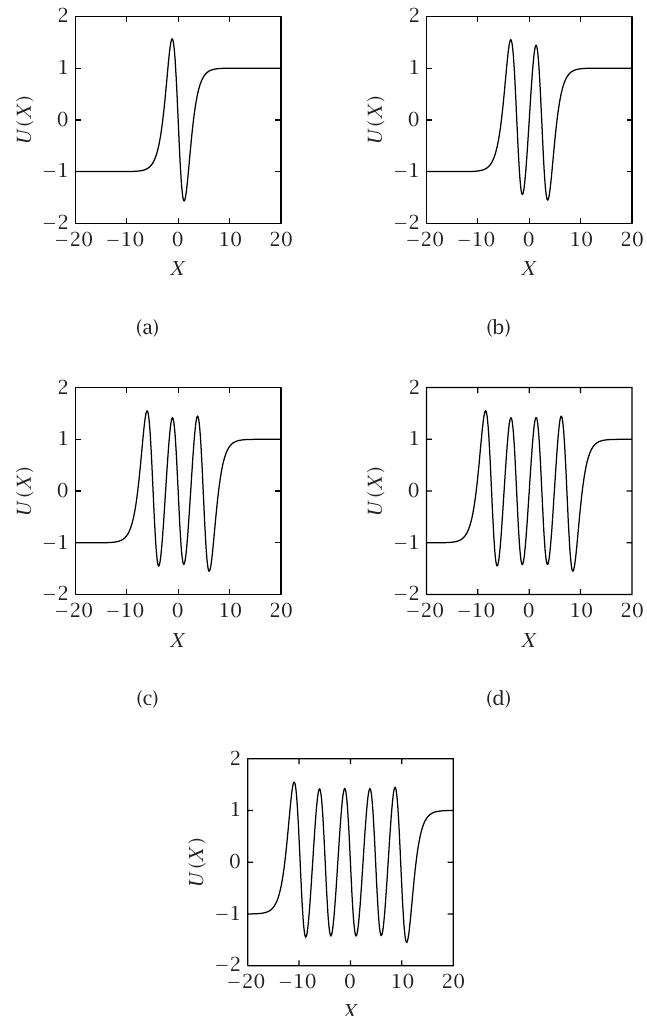
Figure 3.1 . Numerical solutions for the first family of regular shocks: (a) γ = 0 . 36083977, (b) γ = 0 . 34877725, (c) γ = 0 . 34930413, (d) γ = 0 . 34928172, (e) γ = 0 .